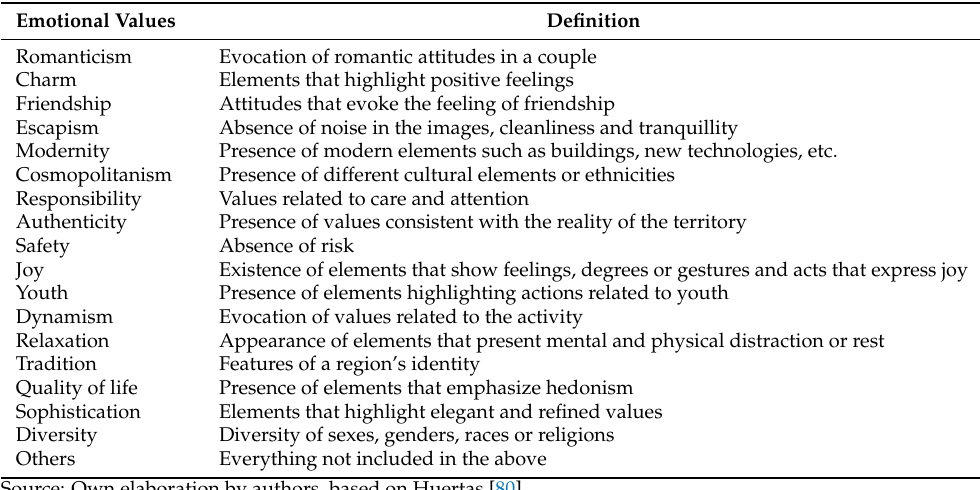
Table 3. Definition of emotional values.